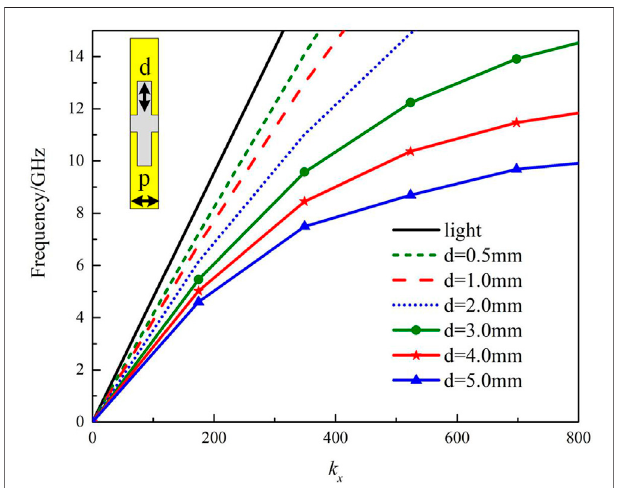
FIGURE 1 | The wavenumber k x of SSPP unit under different dimensions. Inset: the structure of the complementary SSPP unit with dimensions labelled.